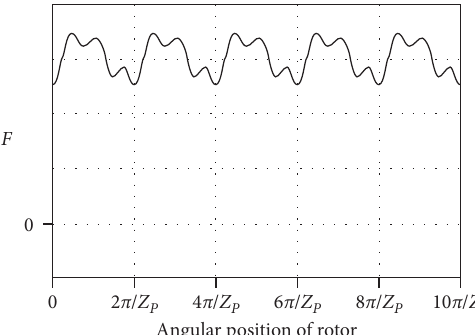
Figure 12: Shape of magnetic force (schematically from Kang et al., 2017).